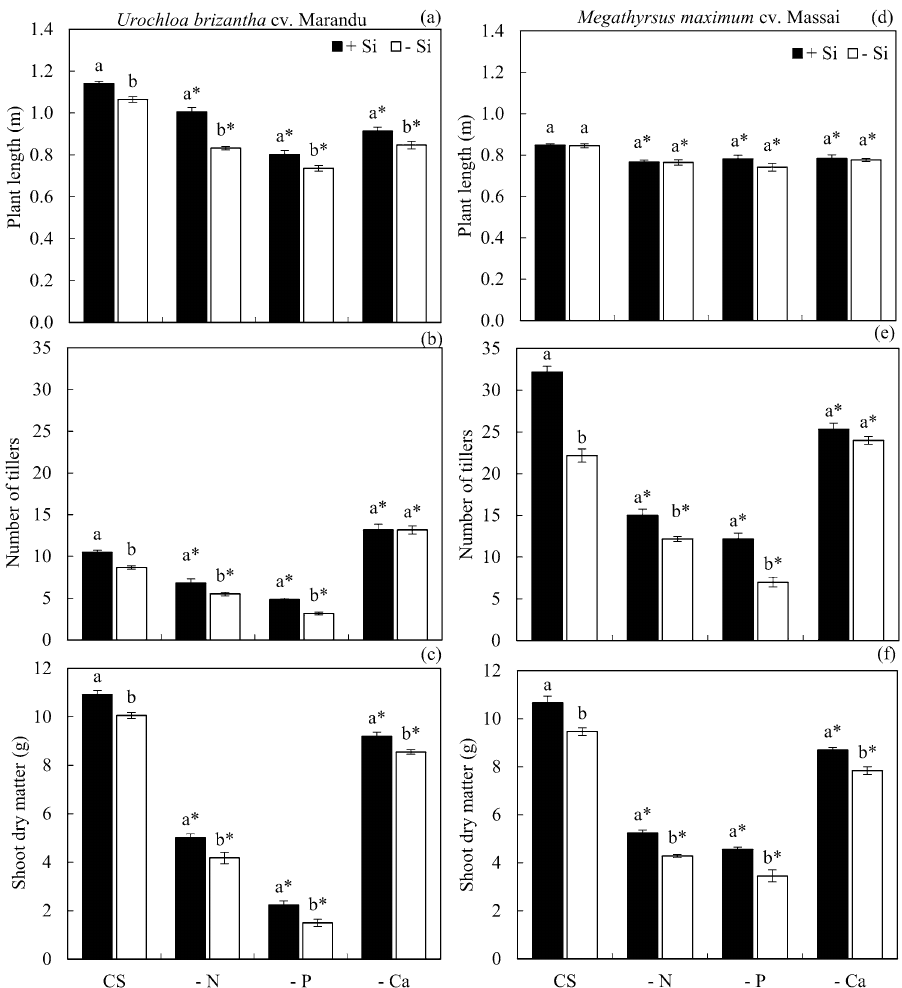
Figure 5. Plant length ( a , d ), number of tillers ( b , e ) and shoot dry matter ( c , f ) of plants of Urochloa brizantha cv. Marandu and Megathyrsus maximum cv. Massai under grown in complete solution (CS) and deficiency of nitrogen (−N), phosphorus (−P) and calcium (−Ca), combined with Si (+Si) and without Si (−Si). Different letters indicate a significant difference between treatments in the +Si and −Si condition. *Indicates a significant difference between treatments with nutritional deficiencies in relation to treatments with CS, by the Tukey test ( p <